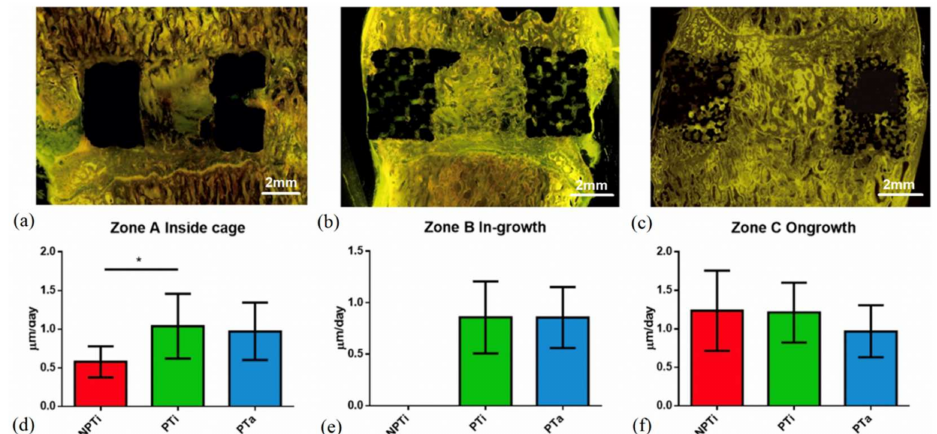
Figure 8. In vivo bone growth rate evaluated through fluorescence microscopy and labeled with tetracycline. ( a ) Nonporous titanium cage (NPTi); ( b ) 60% porous titanium cage (PTi); ( c ) porous tantalum cage (PTa); ( d ) A = bone inside cage between two endplates (bone graft), B = inside of cage (bone ingrowth), and C = bone surrounding the implant (bone ongrowth); ( e ) bone growth in Zone A; ( f ) bone growth in Zone B. ( n = 6), * p < 0.05.